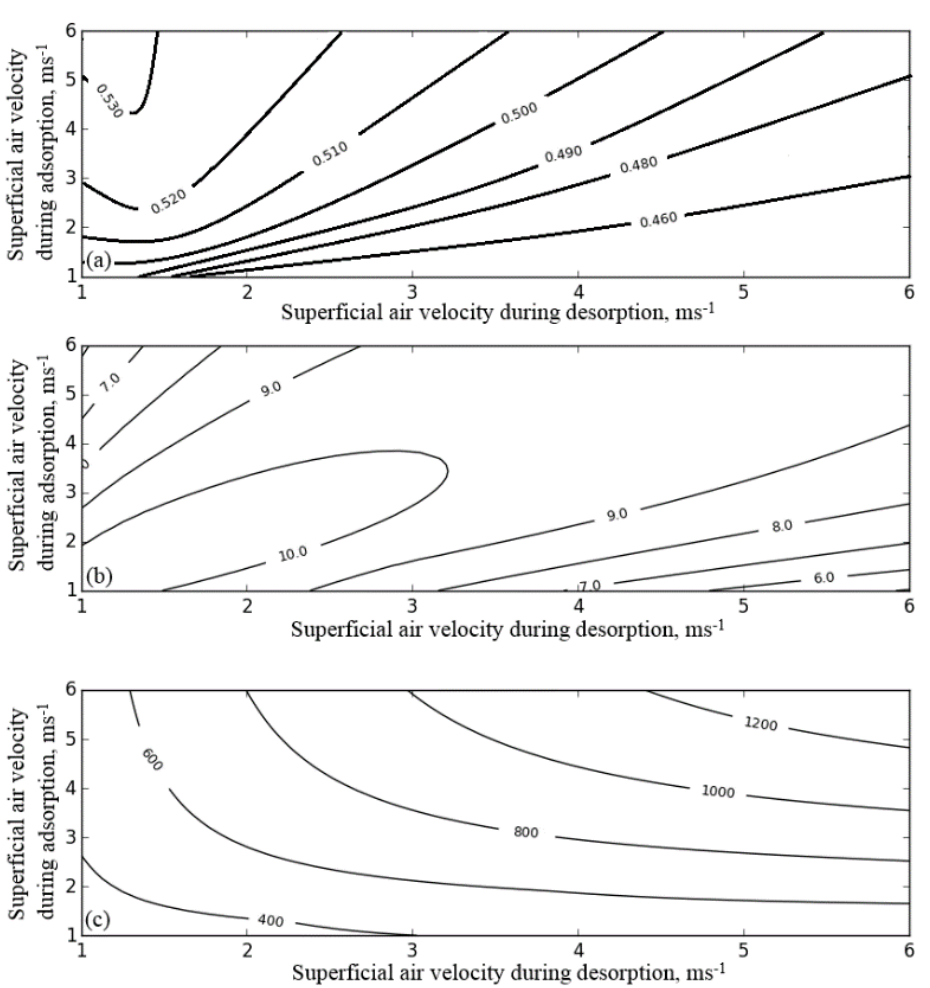
Figure 11. The influence of superficial air velocity on: ( a ) thermal COP ; ( b ) electric COP ; ( c ) SCP .